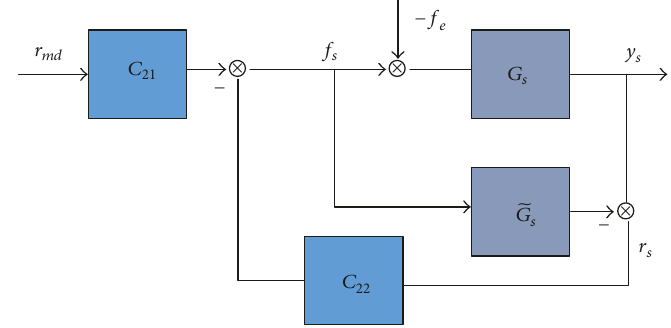
Figure 2: IMC structure of the slave subsystem.